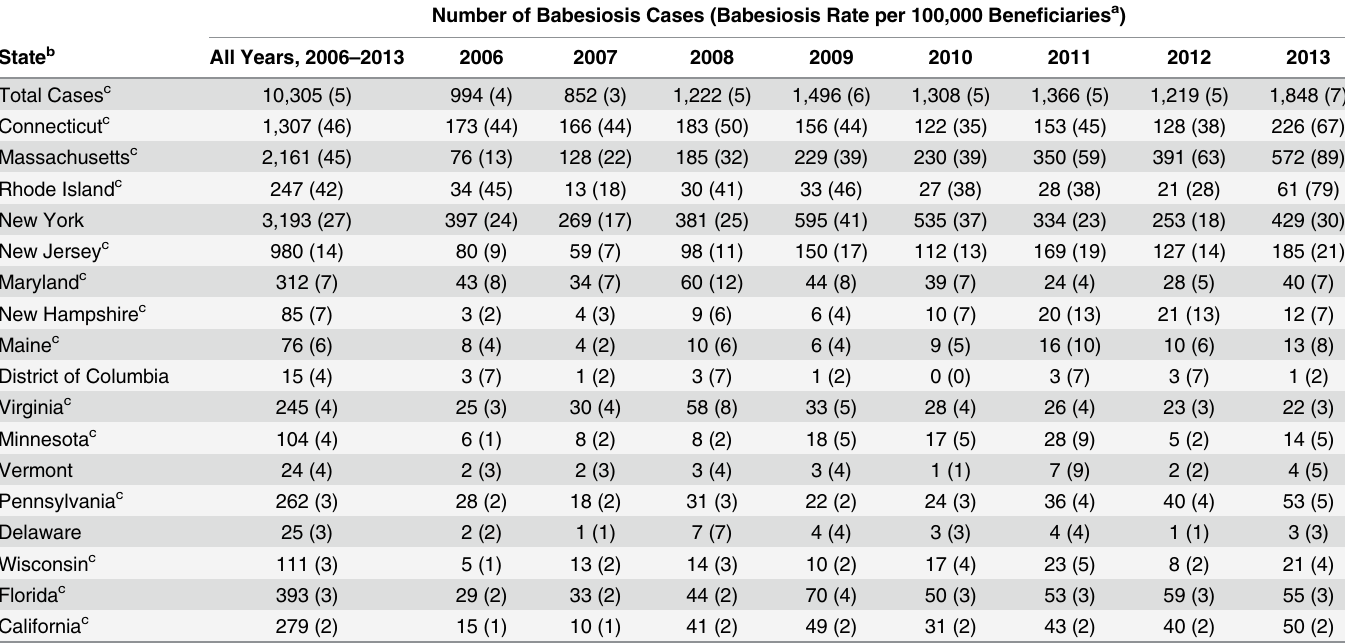
Table 2. Babesiosis Cases and Rates among Elderly Medicare Beneficiaries, Overall and by State, During 2006 –